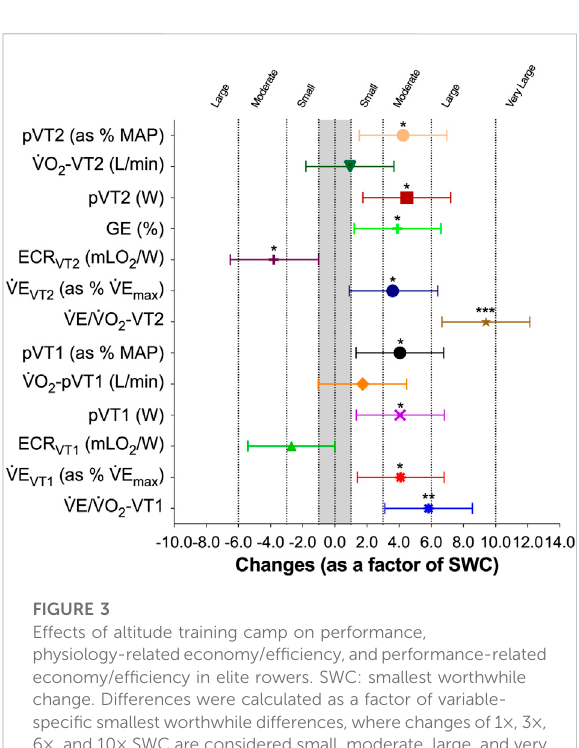
FIGURE 3 Effects of altitude training camp on performance, physiology-relatedeconomy/ef fi ciency,andperformance-related economy/ef fi ciency in elite rowers. SWC: smallest worthwhile change. Differences were calculated as a factor of variable- speci fi c smallest worthwhile differences,where changes of 1×, 3×, 6×, and 10× SWC are considered small, moderate, large, and very large. Symbols and whiskers represent mean ±